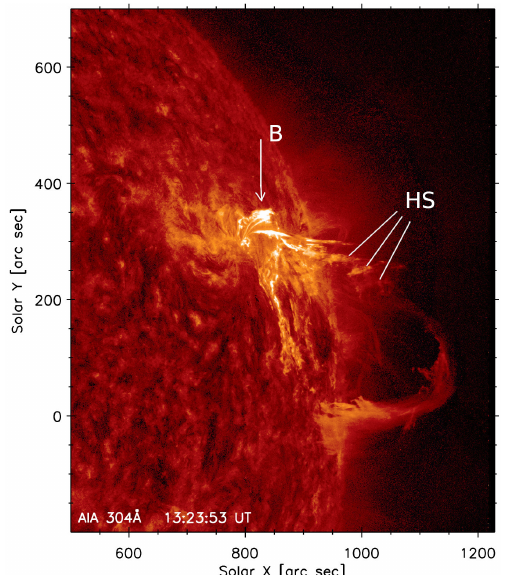
Figure 7. The AIA/SDO 304Å image was taken at 13:23:53UT. The letters HS mark three bright features showing the helical structure of the magnetic rope and the letter B brightenings near the magnetic rope footpoint.